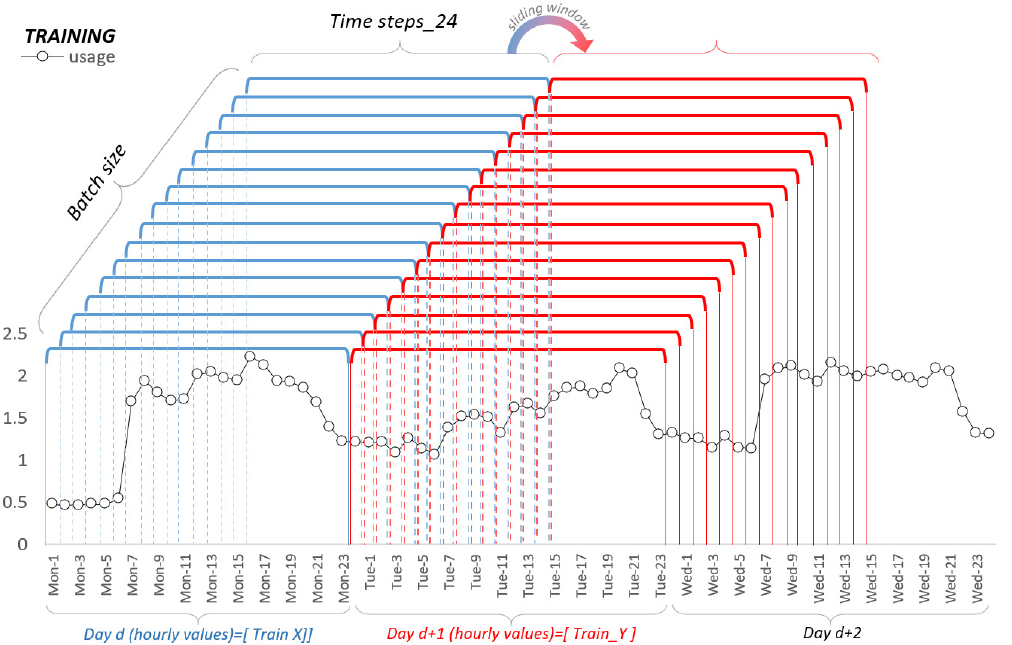
Figure 7. Sliding window for